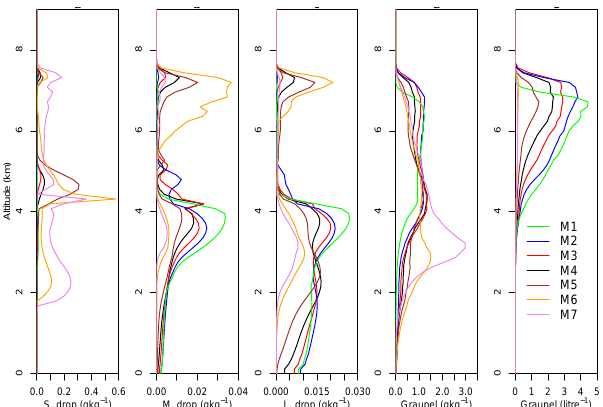
Fig. 14. As Fig. 13, but at 25min.